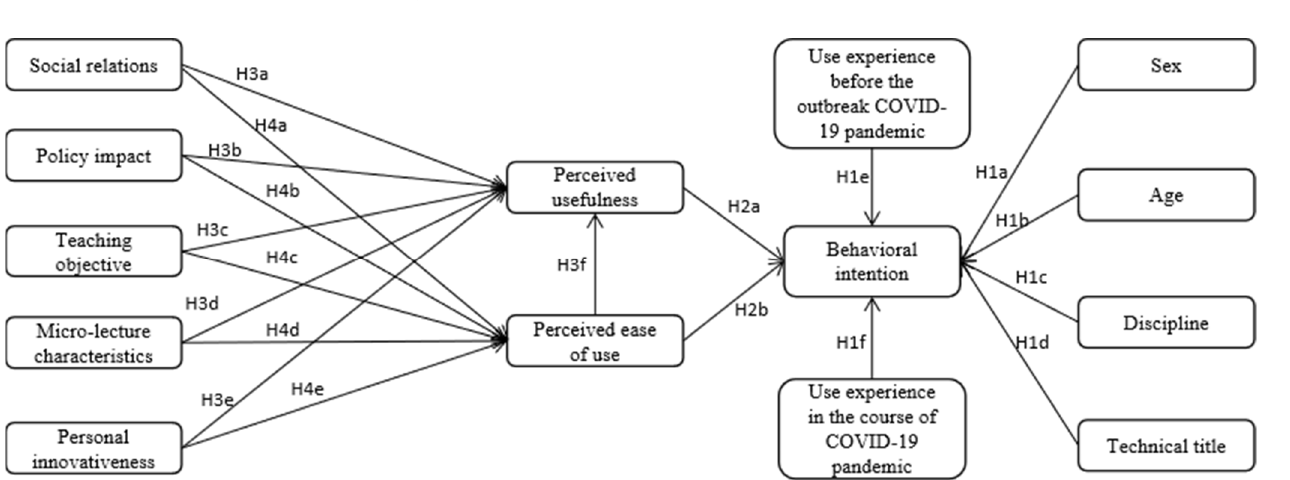
Figure 2. The research model of factors influencing university teachers’ intentions for using micro- lecture in the post COVID-19 era.